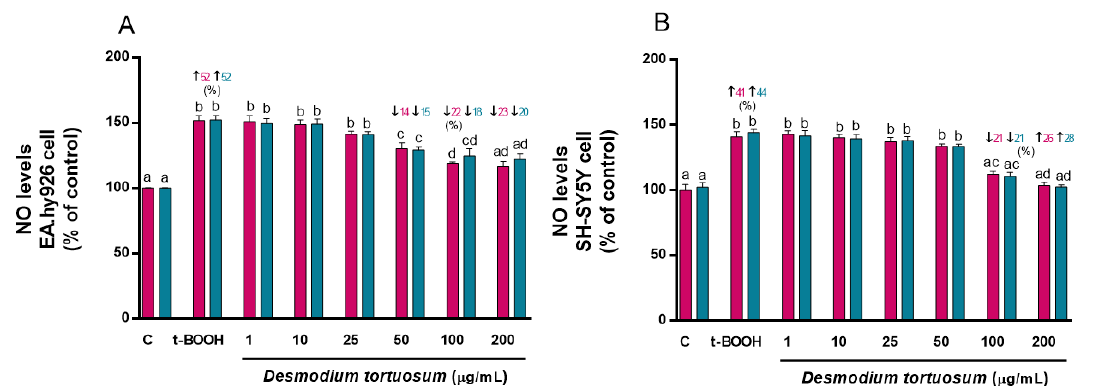
Figure 3. D. tortuosum extract effect on NO levels induced by t-BOOH in EA.hy926 ( A ) and SH-SY5Y ( B ) cells after co-treatment (red bars, █ ) and pre-treatment (blue bars, █ ) periods. NO levels are presented as % of control-change. Data represent the mean ± SEM of six independent experiments. a,b,c,d Different letters show significance between groups at p < 0.05. ↑ represents percentage increase with respect to control, ↓ represents percentage decrease with respect to